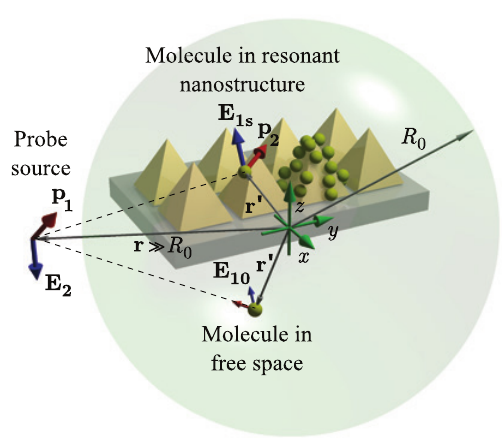
Figure 1: An illustration of the concept of the Raman gain: the molecule near a resonant nanopyramid array (top), at a large distance from the field source, the probe dipole p molecule in free space (bottom) at the same distance from the